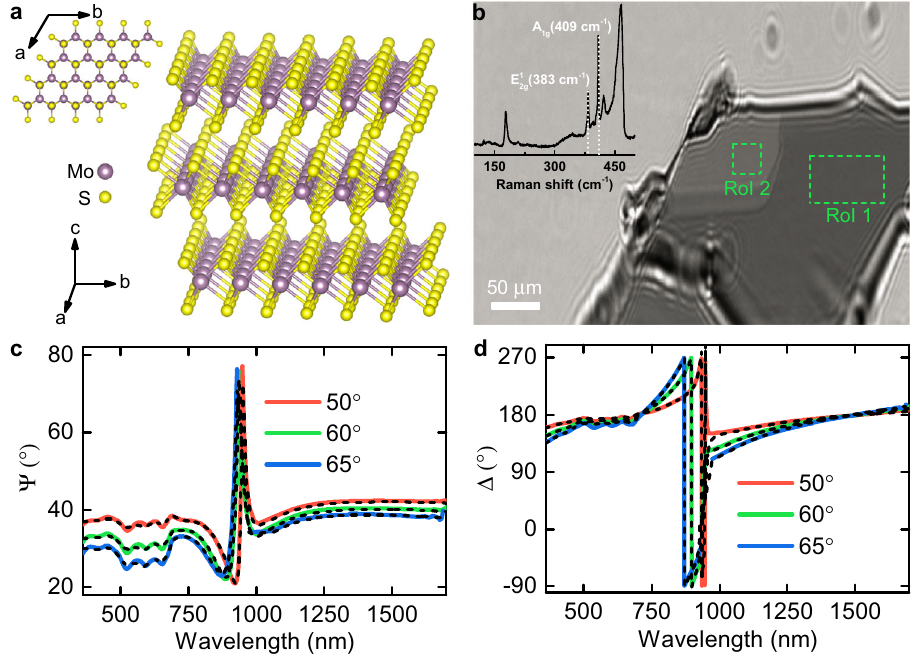
Fig. 1 Anisotropy in MoS 2 . a Schematic illustration of the MoS 2 layered structure: the giant anisotropy between ab -plane and c-axis arises from different interlayer (weak van der Waals bonding) and intralayer (strong ionic/covalent bonding) atomic interactions. b Optical ellipsometer microscope image of the exfoliated MoS 2 thin fi lm on a 285 nm-thick SiO 2 /Si substrate at 65°. The ellipsometry measurements were performed in two uniform areas marked by green dashed lines. The inset shows a resonant Raman spectrum at an excitation wavelength λ = 632.8 nm with the characteristic modes E 1 and A 1 g = 409 cm − 1 , whose positions con fi rm the 2H semiconducting material con fi guration. c , d Experimental (solid lines) and analytically calculated (dashed lines, see Methods) ellipsometric parameters Ψ and Δ for ROI 1 ( Ψ and Δ for ROI 2 see in Supplementary Note 2) at three incident angles 50°, 60°, and 65°. The asymmetric interference-like peak at around 900 nm is induced by interference enhancement in SiO 2 caused by splitting the incident beam into ordinary and extraordinary beams indicating a giant anisotropy in MoS 2